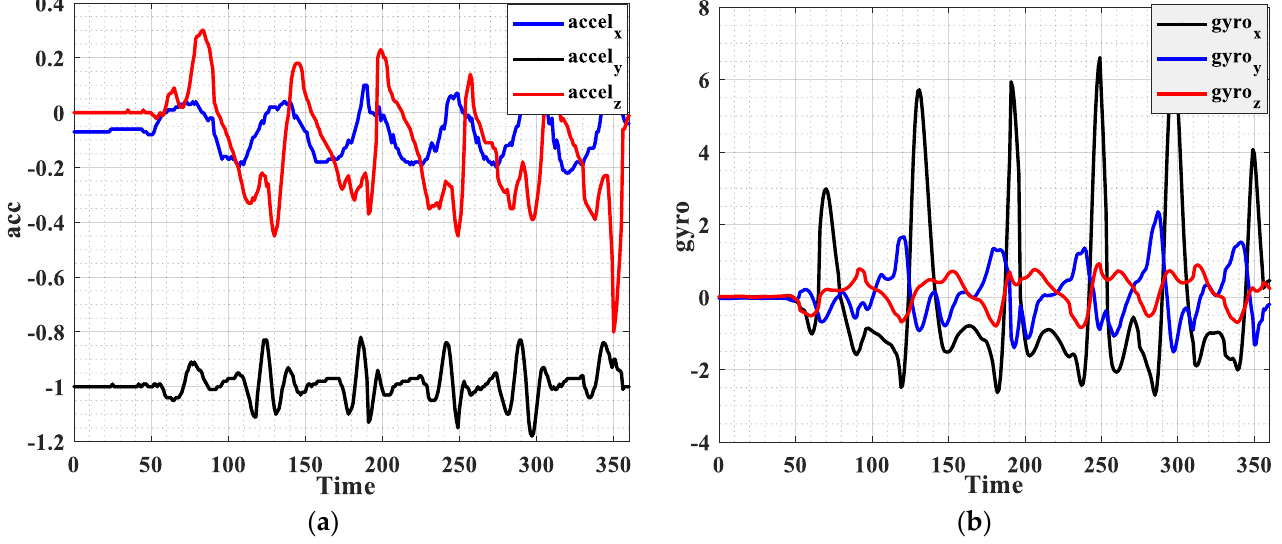
Figure 7. Right foot IMU walking data. ( a ) Acceleration information; ( b ) angular velocity information. It is necessary to partition the plantar pressure information before extracting features is divided into four stress areas (toe, forefoot, arch, and heel), and then the data of each stress point in the stress area are summed up and the average value is taken as the stress size of the